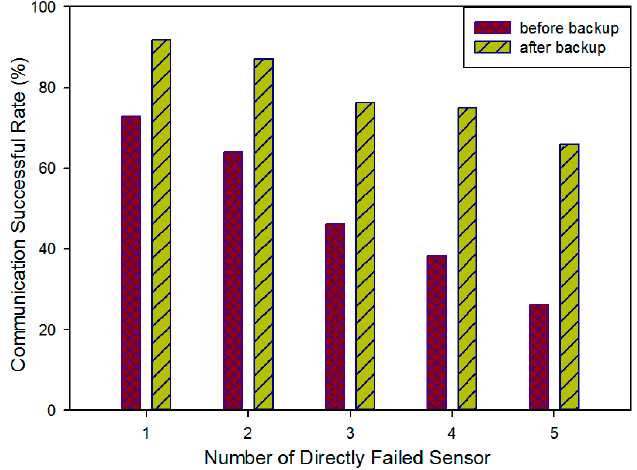
Figure 16. Communication successful rate before and after backup on-road sensor deployment.